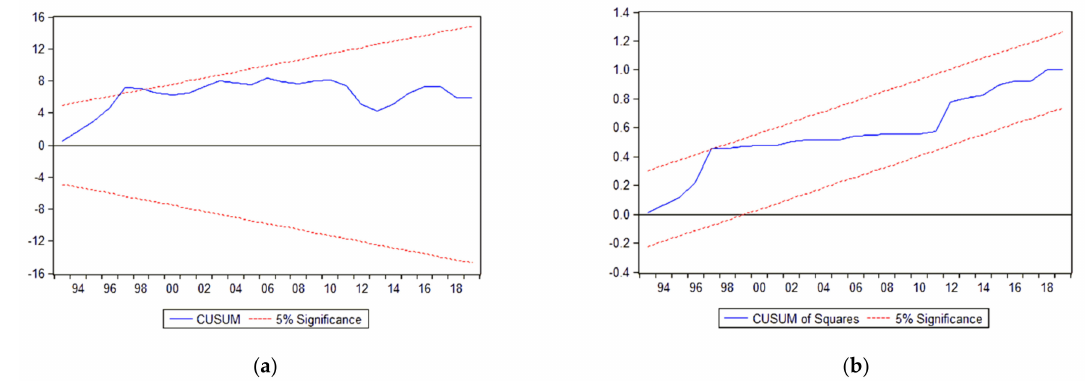
Figure A6. The breakpoint testing for the linear form assumption: ( a ) CUSUM; ( b ) CUSUMSQ. Table A9. Granger causality